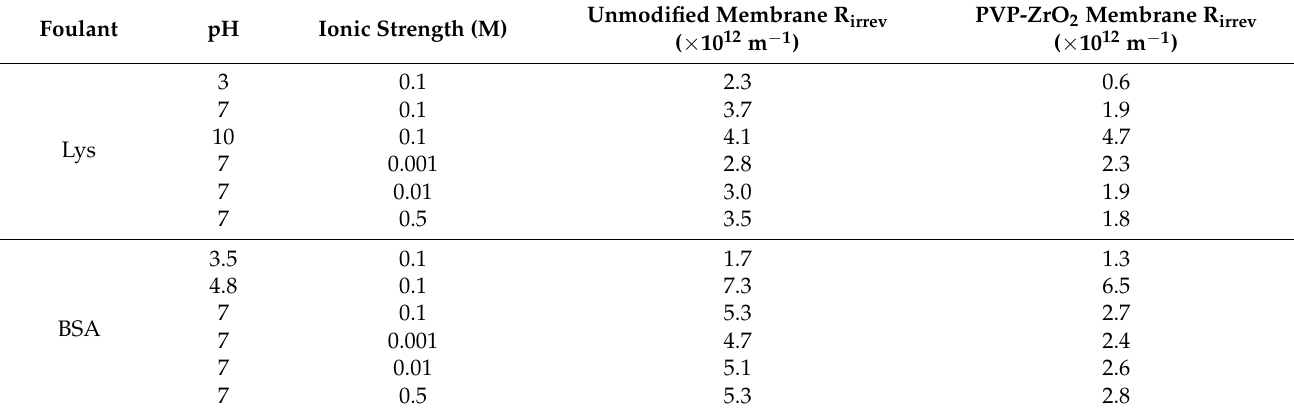
Table A2. Summary of irreversible fouling resistance for unmodified and PVP-tethered Zirconia